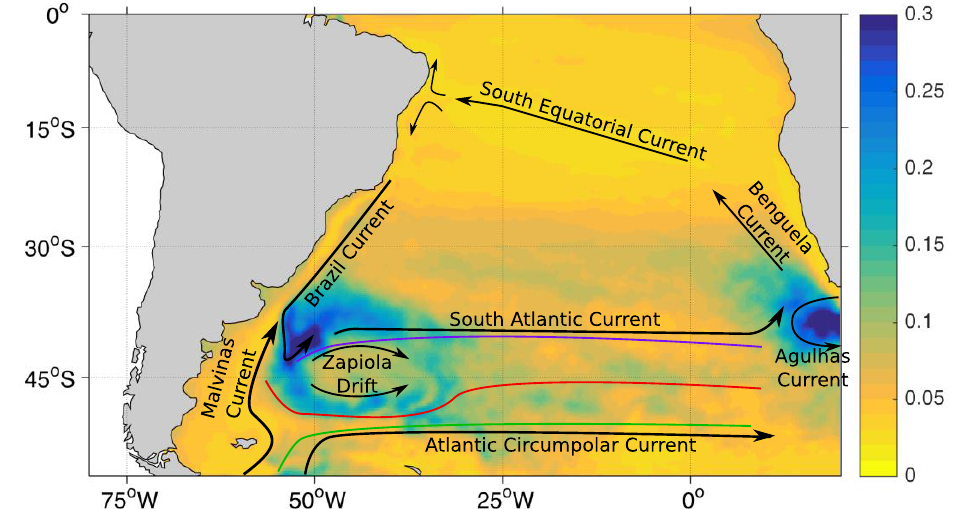
Figure 1. Map of the standard deviation of 25 years of sea level anomaly (m) derived from CMEMS. Black arrows represent the main currents of the South Atlantic. The Subtropical Front, Subantarctic Front and Polar Front are indicated by the violet, red and green lines, respectively .